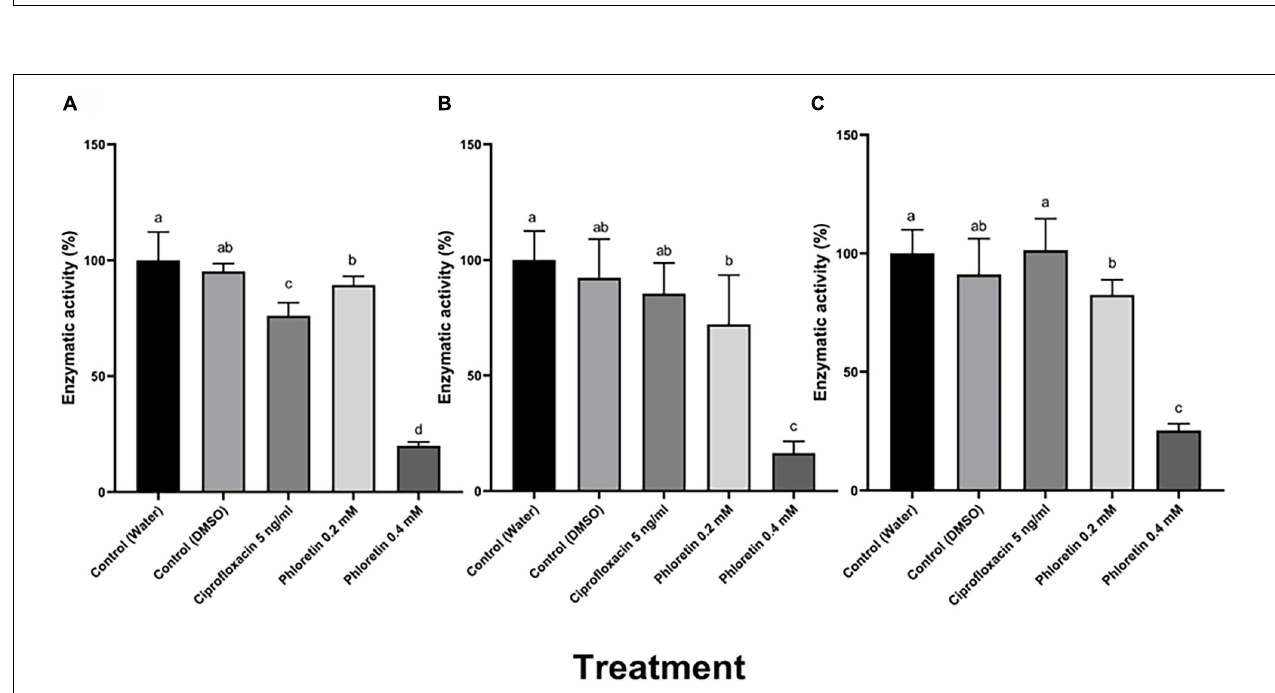
FIGURE 2 | Effects of different concentrations of phloretin on exoenzyme activities in Pectobacterium brasiliense (Pb1692). (A) Pectate lyase (Pel) activity, (B) polygalacturonase (Peh) activity, (C) protease (Prt) activity. Extracellular enzyme activity was determined based on the halo area of substrate degradation. Results are expressed as the percentage of activity relative to controls (bacteria exposed to dH 2 O or 0.3% DMSO), bacteria were exposed to 0.2, 0.4 mM phloretin or ciprofloxacin, 5 ng/mL (50% growth inhibiting concentration). The Tukey-Kramer HSD test was used to analyze the differences. Bars that are not labeled with the same letter are significantly different from each other ( P < 0.05; n = 16); Data represent means ± SE of 2 independent experiments, each with 8 replicates.